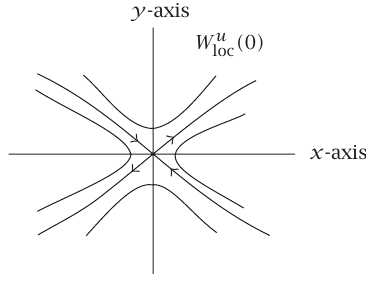
Figure 5.6 . The local phase space of